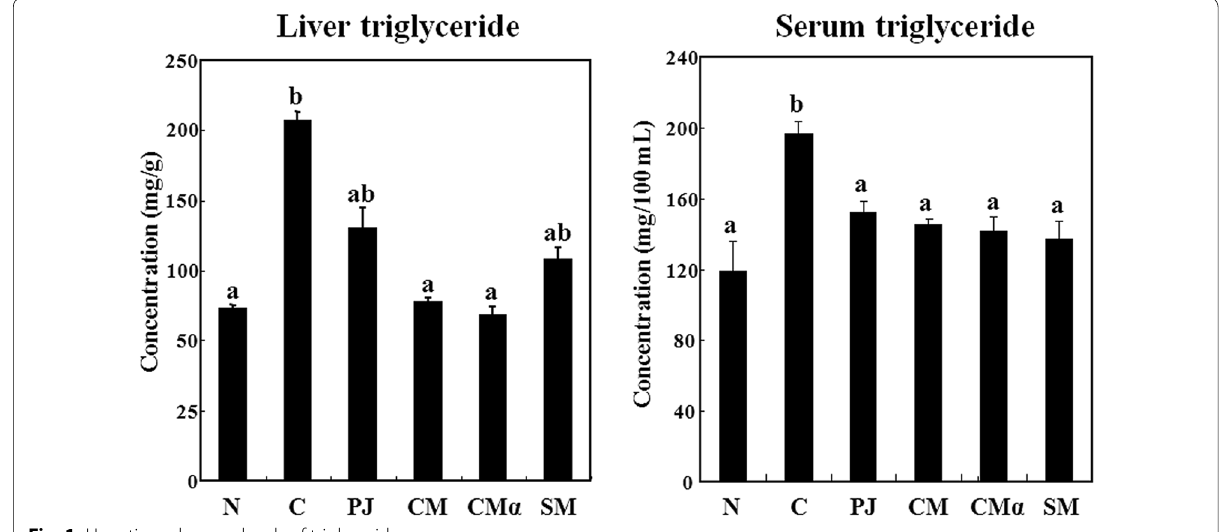
Fig. 1 Hepatic and serum levels of triglyceride